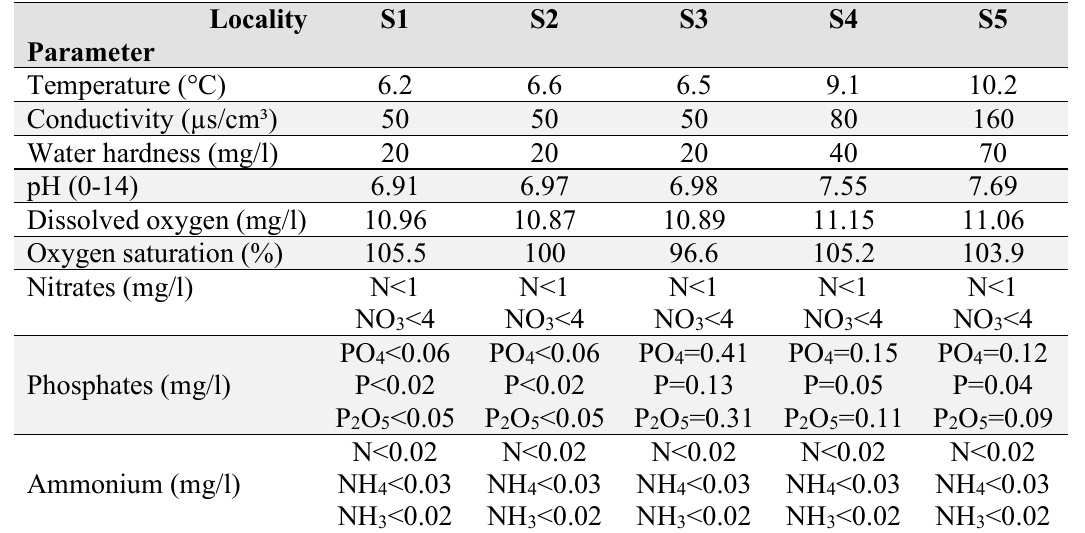
Table 2. Physical and chemical parameters of water of the Samokovska River in October 2018 Locality